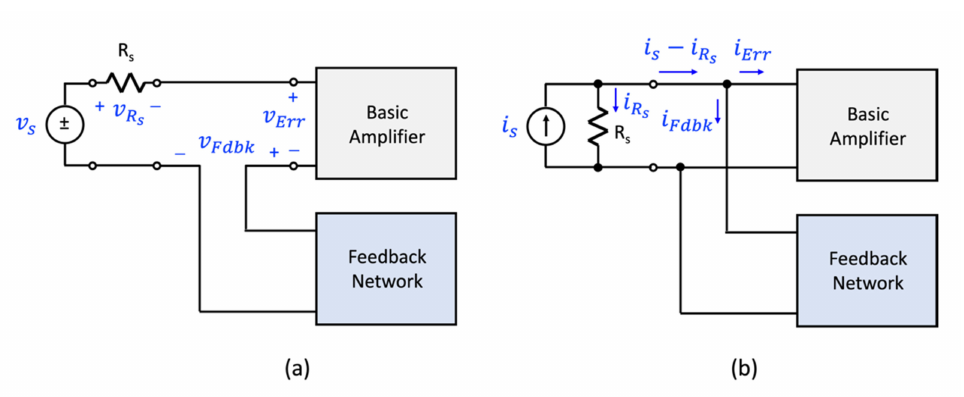
Figure 3. Highlighting problem with voltage and current mixing when a source resistance is present. ( a ) voltage mixing, and ( b ) current